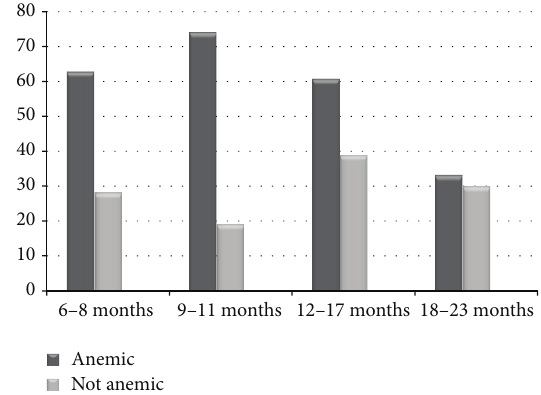
Figure 2: Number of children (6–23 months) with anemia by age